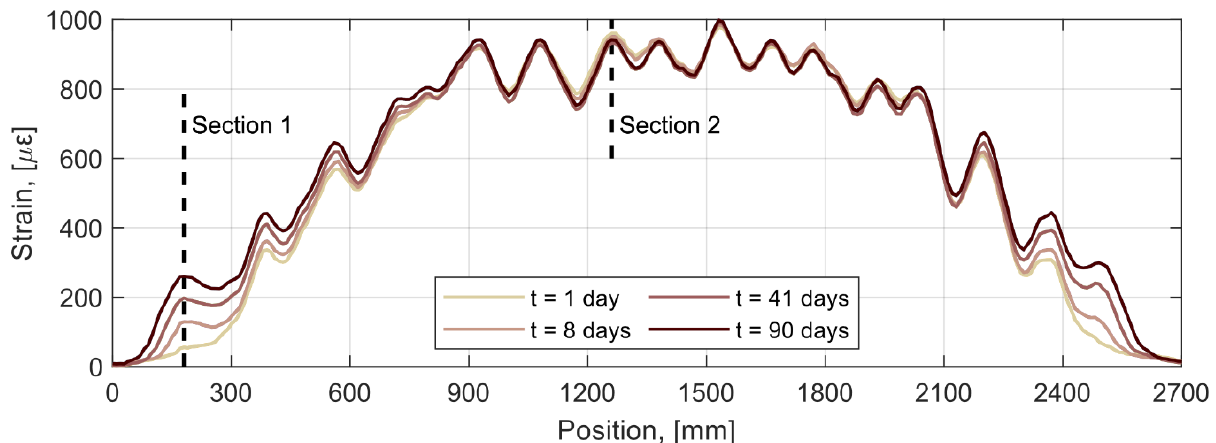
Figure 8. Strain profiles at the tensile reinforcement of beam 4 at different times for a loading cycle of ca. 28.5 kN.